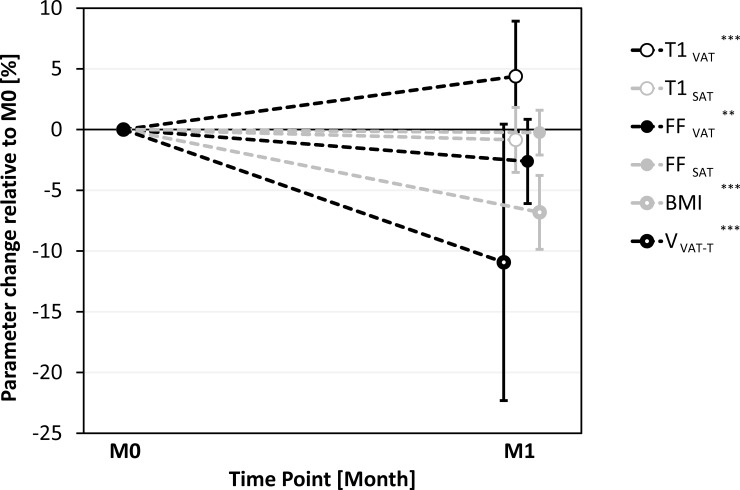
Plot of relative changes in adipose tissue parameters for 23 obese patients one month after bariatric surgery.Symbols show mean percent changes in BMI, total abdominal VAT volume (VVAT-T), regional fat fraction in visceral and subcutaneous adipose tissue (FFVAT and FFSAT), and corresponding T1 relaxation times (T1VAT and T1SAT) one month after (M1) relative to before bariatric surgery (M0). Error bars indicate 95% confidence intervals. Asterisks denote level of significance: * (p<0.05), ** (p<0.01), *** (p<0.001). Some symbols have been slightly offset to improve readability.